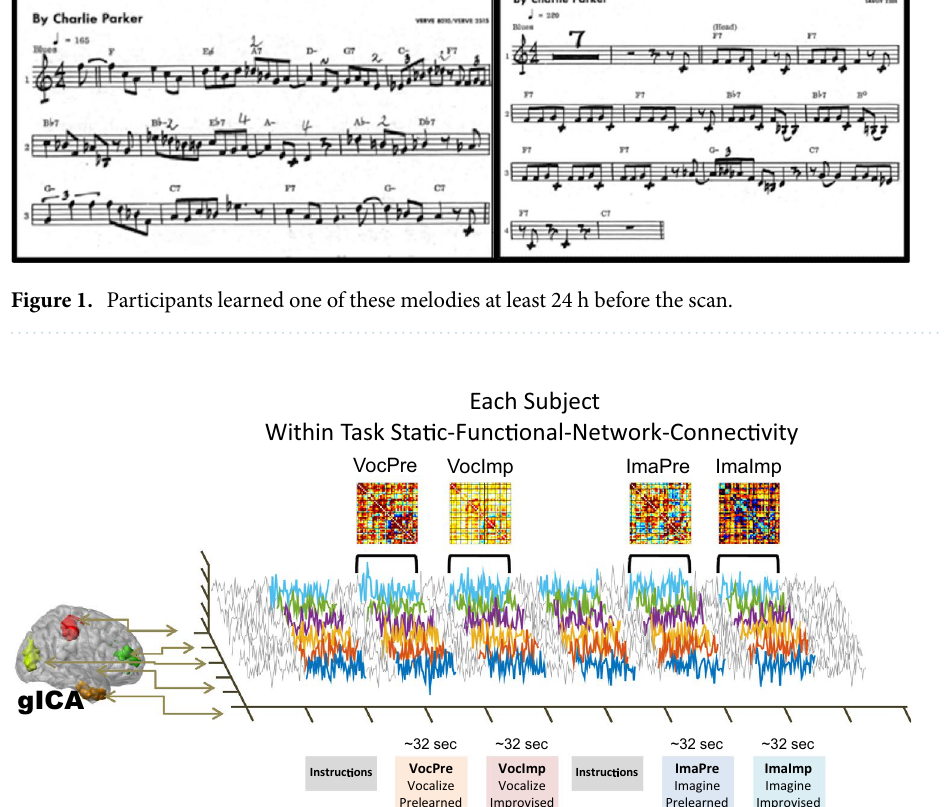
Fig. 2, 741 network-to-network (N2N) connectivity values were estimated using Fisher transformed Pearson correlations (z-values) from time-courses for each task and subject. A One-Way ANOVA was performed for each correlation based on the four tasks. Significance was corrected using the false discovery rate (FDR) method. Post-hoc group tests were performed for each N2N correlation and four different contrasts including ImaPre-ImaImp, VocPre-VocImp, VocImp-ImaImp, and VocPre-ImaPre. We included two additional con- trasts. A Pre-Imp = (VocPre + ImaPre) − (VocImp + ImaImp) contrast which consisted of differences between preleaned (Pre; merging VocPre and ImaPre) and improvisation (Imp; merging VocImp and ImaImp). A Voc- Ima = (VocPre + VocImp) − (ImaPre + ImaImp) contrasts consisted of differences between vocalization (Voc; merging VocPre and VocImp) and imagine (Ima; merging ImaPre and ImaImp). These analyses allowed us to identify brain networks associated with the imagination and vocalization of improvised and prelearned melodic sequences. FDR for multiple comparison correction was applied.